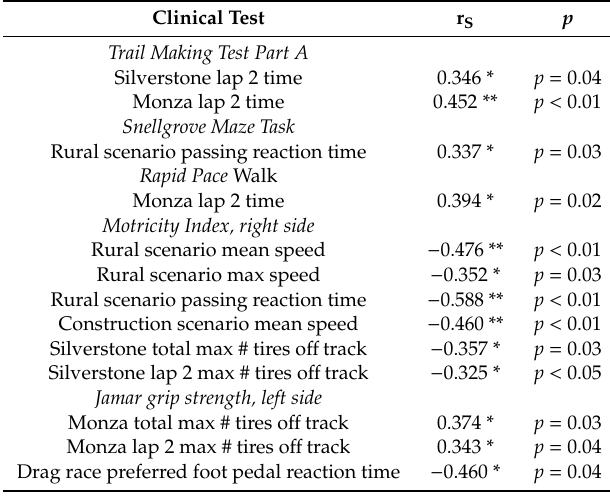
Table 7. Significant spearman correlations of clinical psychometric and motor testing to research and racing simulator outcomes.